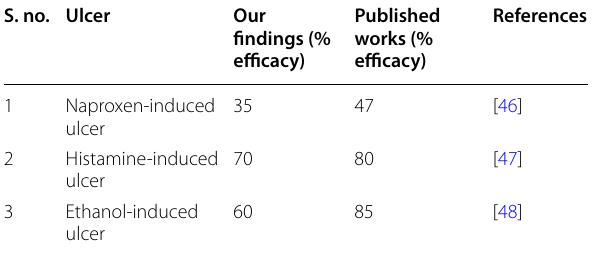
Table 8 Effect of C. zeylanica extract on area of ulcer and ulcer index in ethanol-induced acute